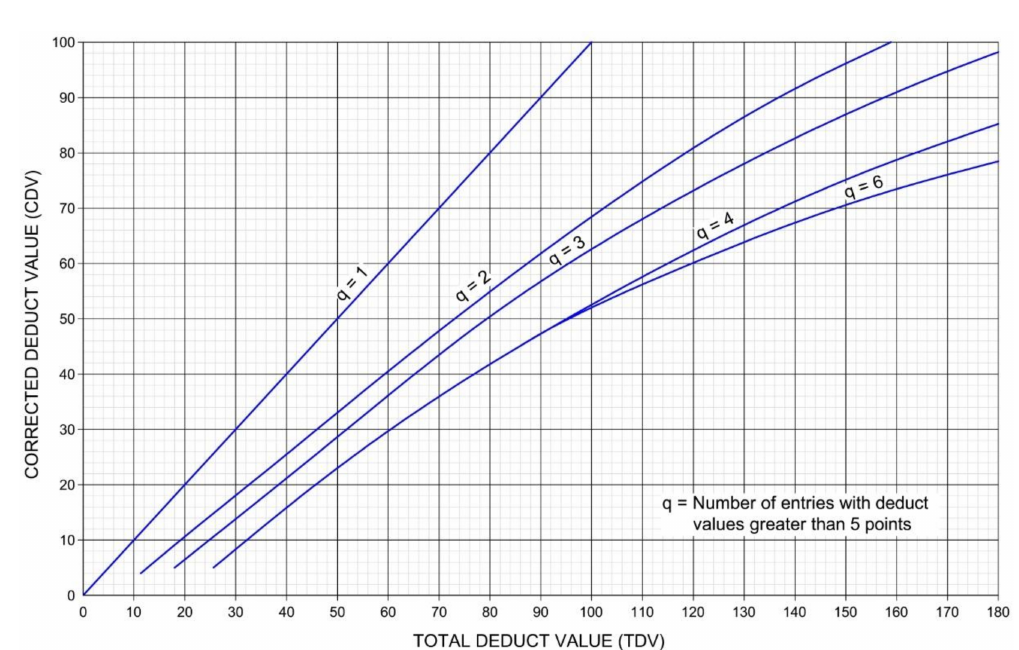
Figure 3. Curves for corrected deduct